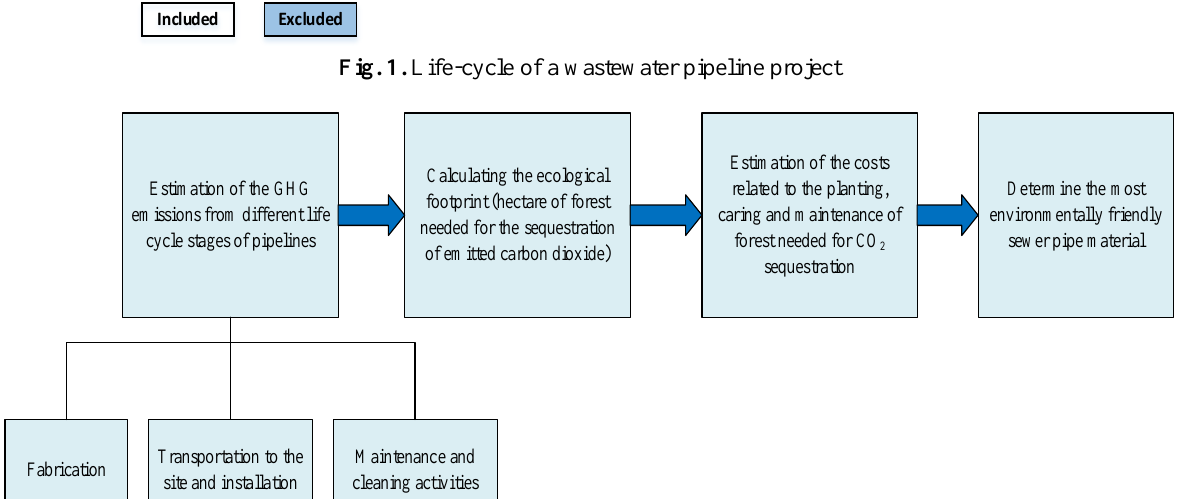
Fig. 1. Life-cycle of a wastewater pipeline project